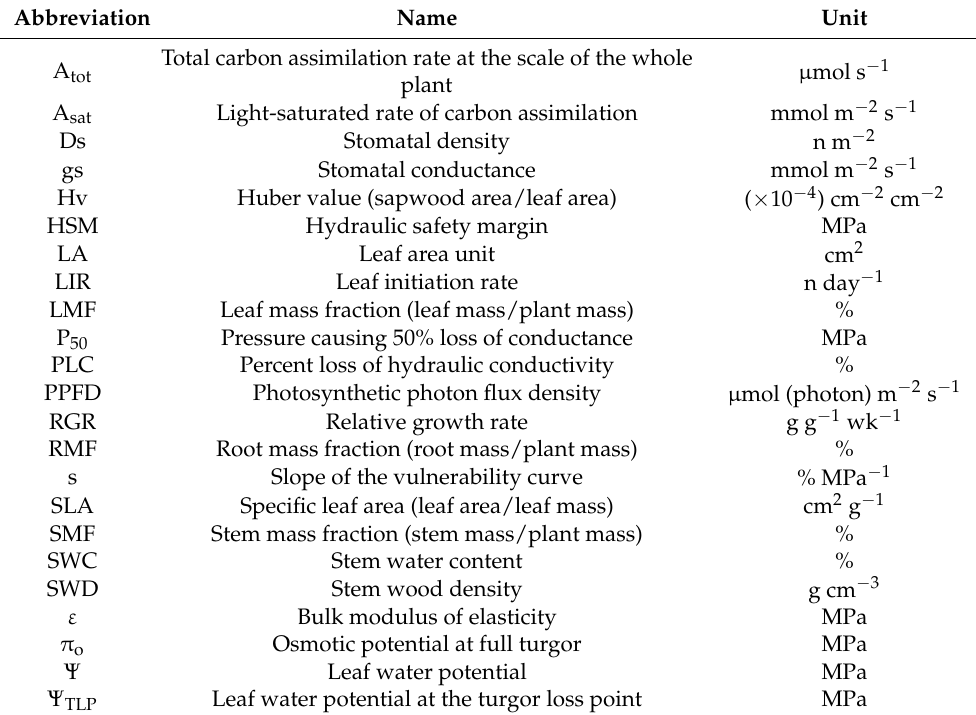
Table 1. Symbols and units for all traits concerning biomass, leaf gas exchange, leaf morphology and anatomy, wood traits, hydraulics and pressure–volume curve